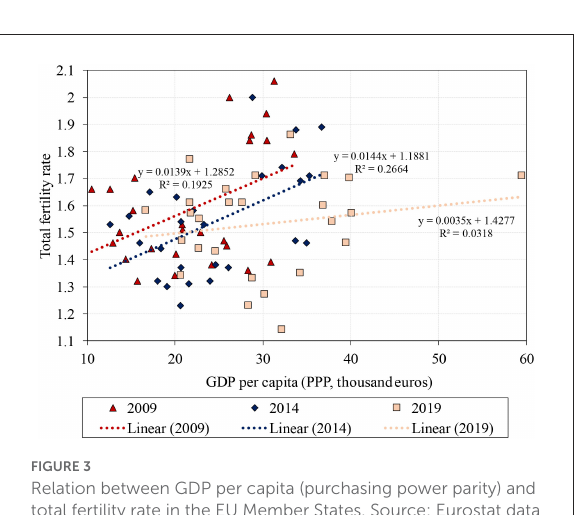
FIGURE3 Relation between GDP per capita (purchasing power parity) and total fertility rate in the EU Member States. Source: Eurostat data downloaded on 5 June 2022 (Luxembourg was omitted as an